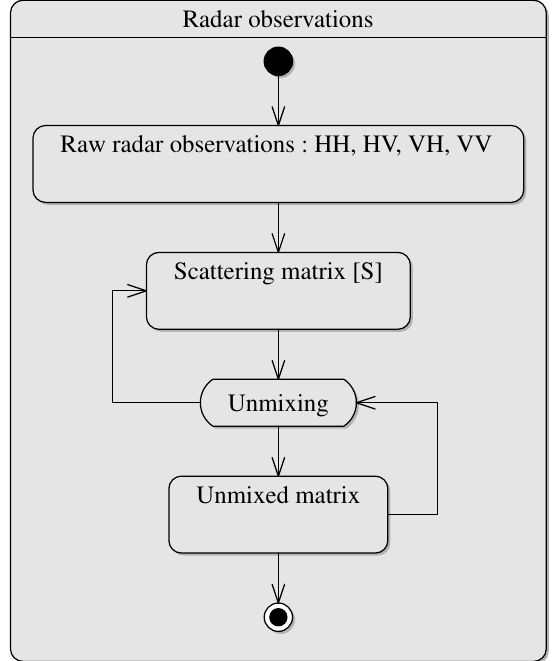
Figure 1: Unmixing the scattering matrix Different states of radar observations The statechart diagram